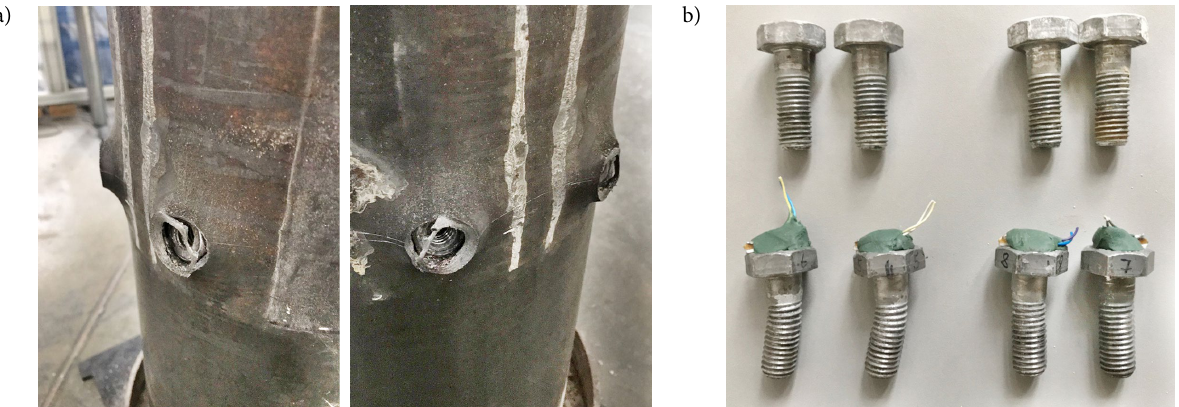
Figure 14. Failure mode: a – punching shear of the column wall; b – deformed bolts (top row – bolts from compression zone; bottom row – bolts from